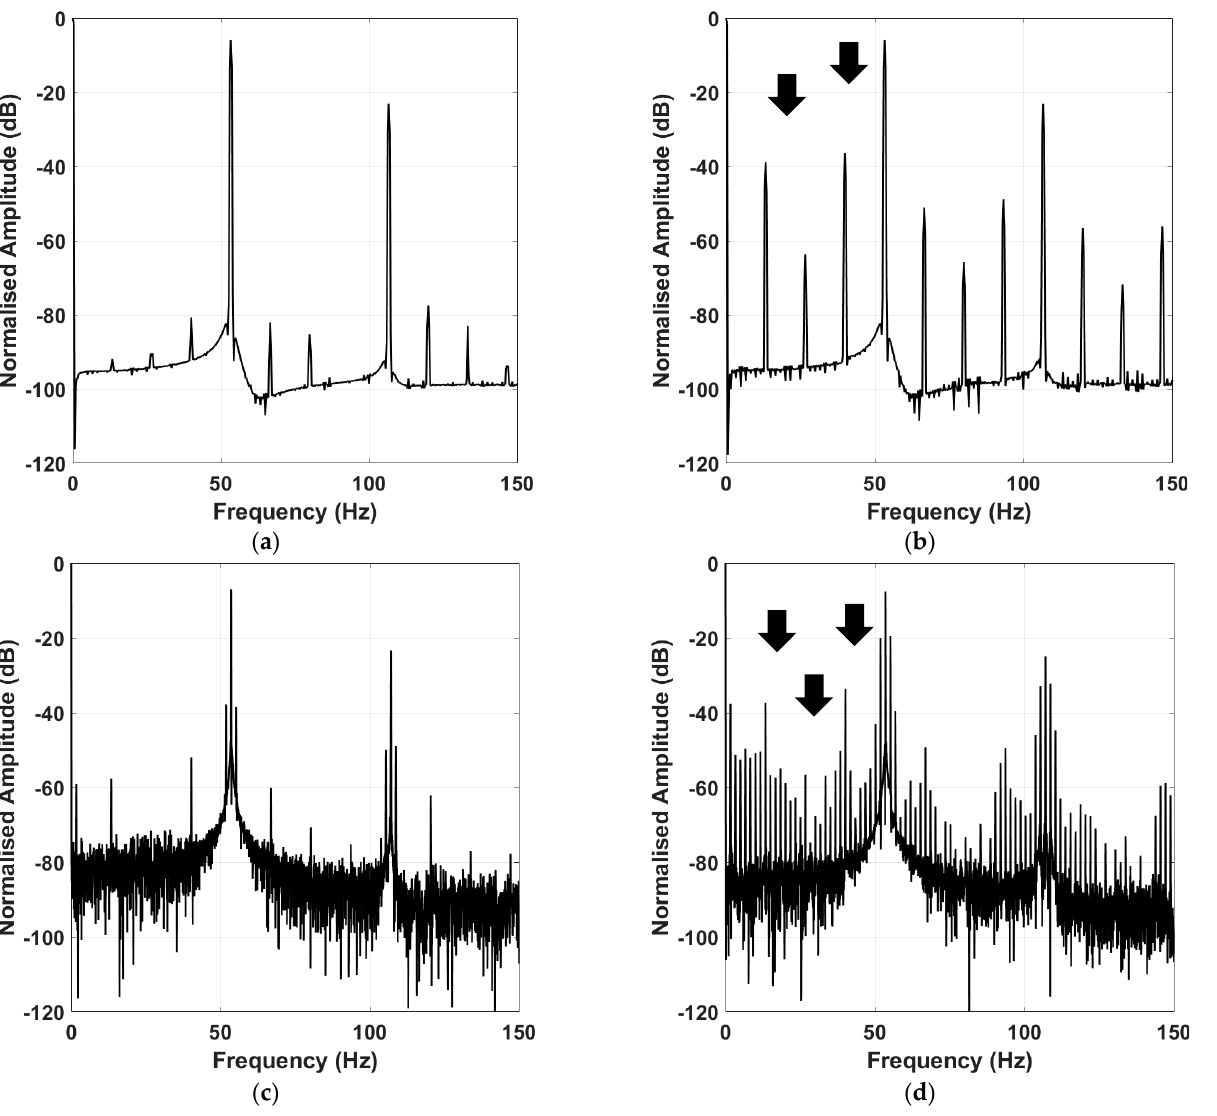
Figure 5. Simulation results. EPVA spectrum of the generator at 100 rpm: ( a ) healthy simulation; ( b ) local demagnetization simulation; ( c ) healthy experiment; ( d ) local demagnetization experiment.